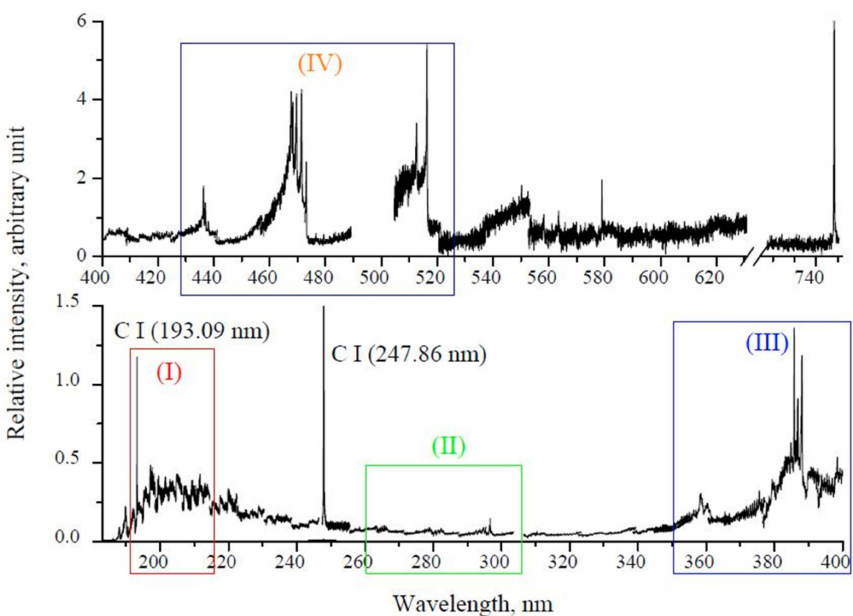
Figure 43. Spectrum of pure CO 2 from VUV to VIS in ICP CORIA torch (from [40]).